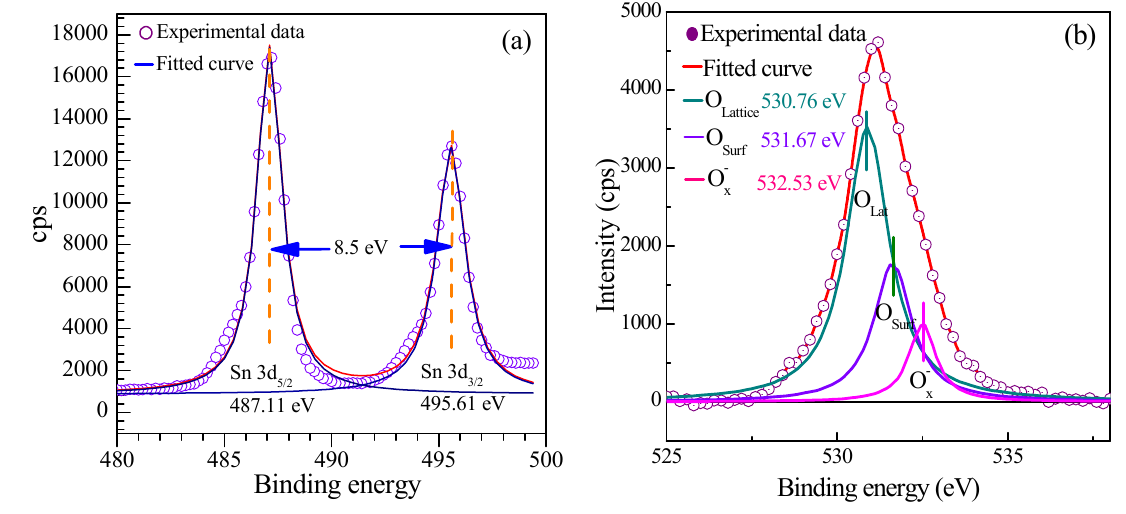
Figure 9. High-resolution XPS spectra of as-prepared SnO 2 nanosheets. ( a ) Sn 3d and ( b ) O 1s.